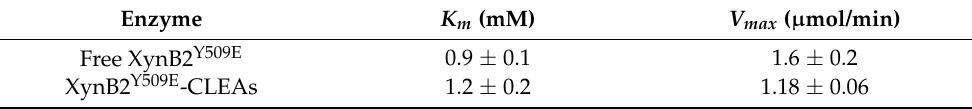
Table 1. Kinetic parameters for the β -xylosidase activity of free XynB2 Y509E and XynB2 Y509E -CLEAs.